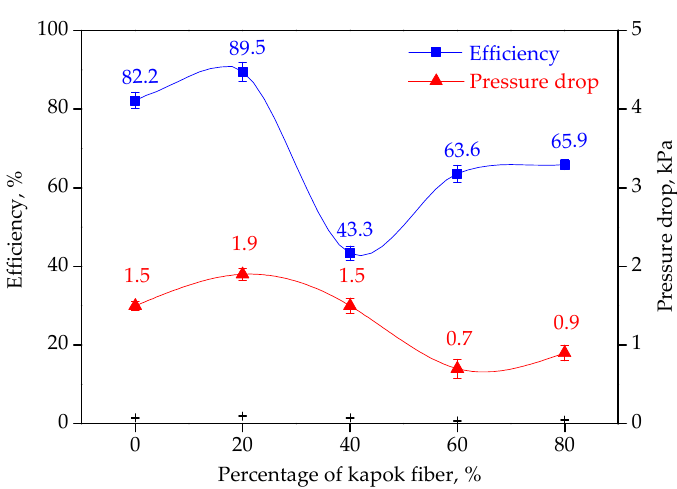
Figure 9. E ff ect of kapok fiber content on separation e ffi ciency and pressure drop of filter media. Figure 9. Effect of kapok fiber content on separation efficiency and pressure drop of filter media.